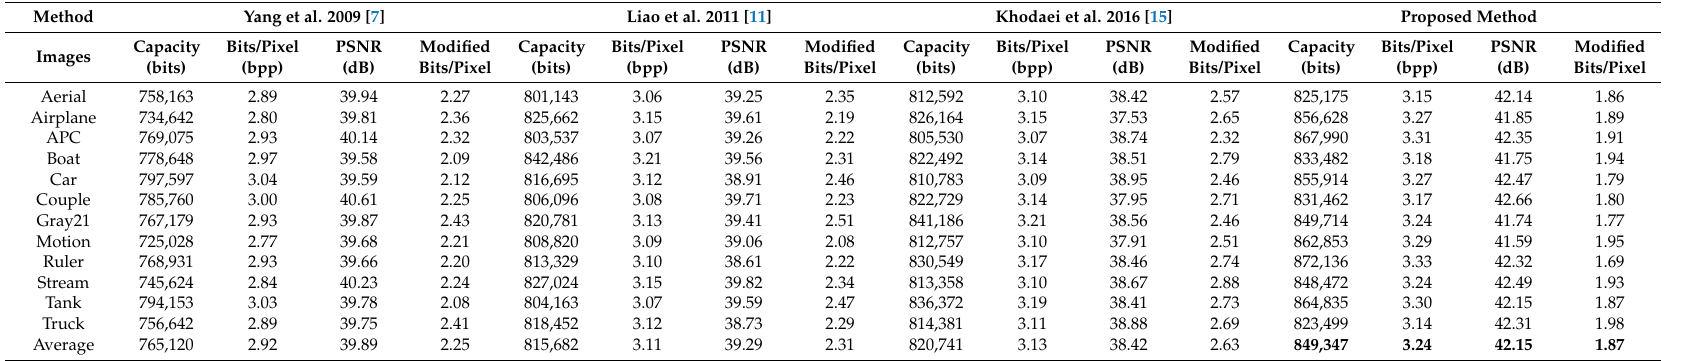
Table 4. Comparison of capacity (bpp), image quality (PSNR), and modified bits with existing methods using USC-SIPI [24] dataset images.